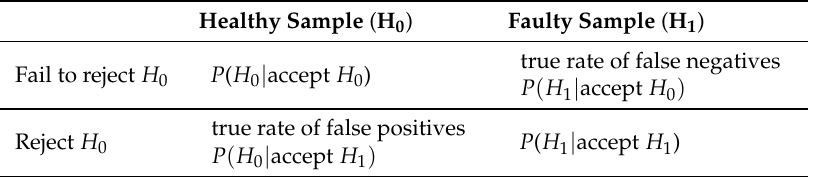
Table 9. Relationship between the proportion of false negatives and false positives and scheme for the presentation of the results in Table 10.